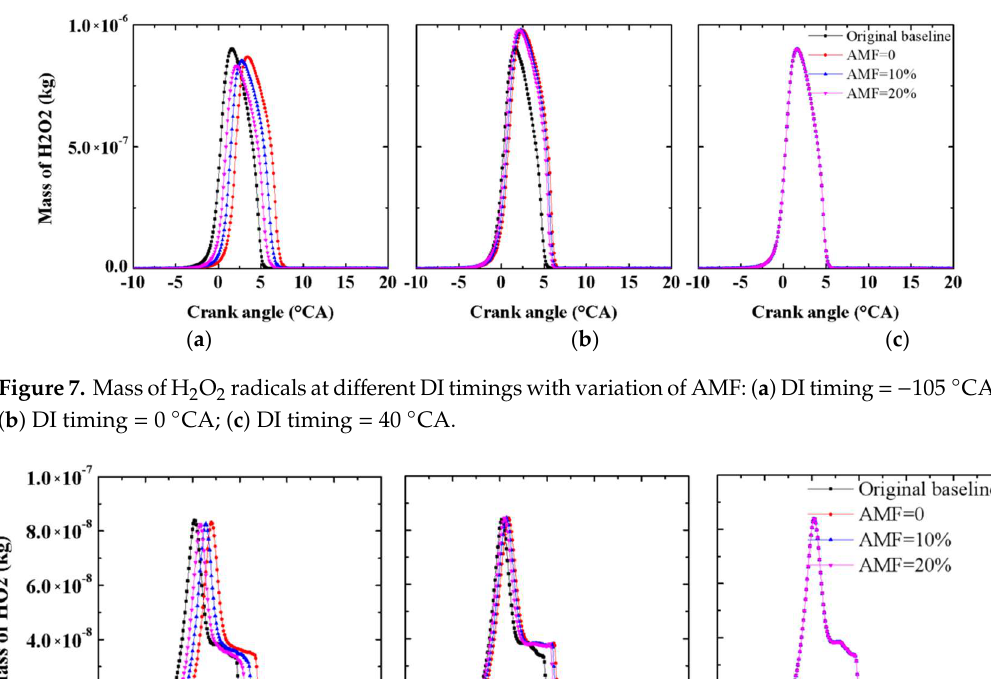
Figure 6. Mass of OH radicals at different DI timings with variation of AMF: ( a ) DI timing = −105 °CA; ( b ) DI timing = 0 °CA; ( c ) DI timing = 40 °CA.